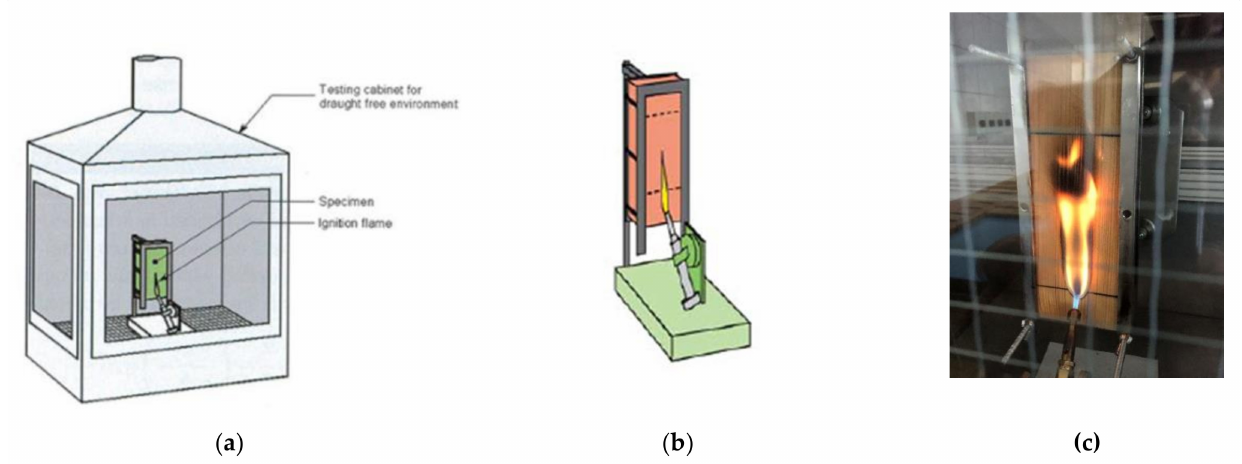
Figure 2. ( a ) Test chamber according to STN EN ISO 11925-2 [66]; ( b ) scheme of small flame test, EN ISO 11925-2 (sample size 0.09 × 0.25 m 2 ) [62,66]; ( c ) demonstration of the experiment on a sample of SMR + HRP (retardant) in 30 s.